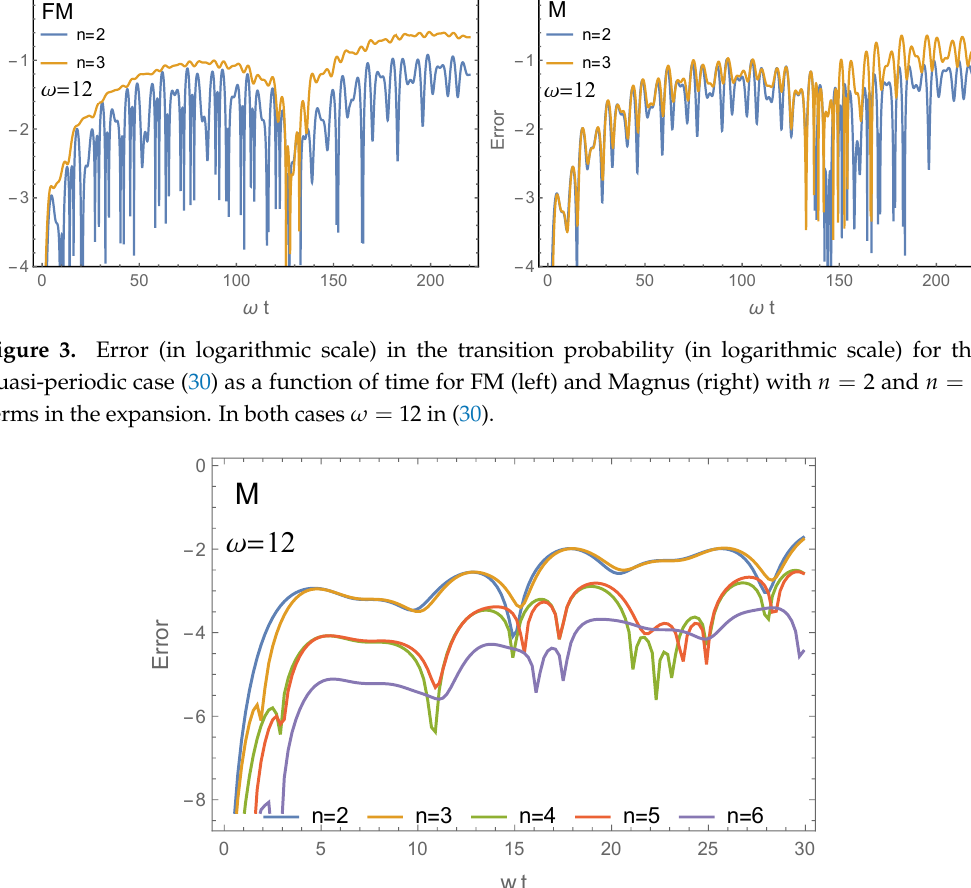
Figure 4. Detail of Figure 3 right in the interval ω t ∈ [ 0,30 ] . We have included up to n = 6 terms in the Magnus